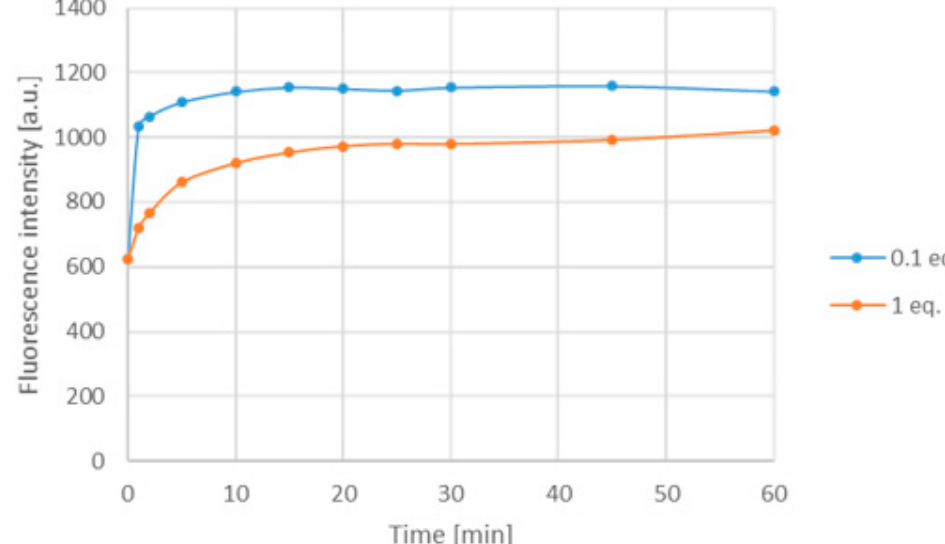
Figure 12. The change of the emission of 12d in water at 537 nm.